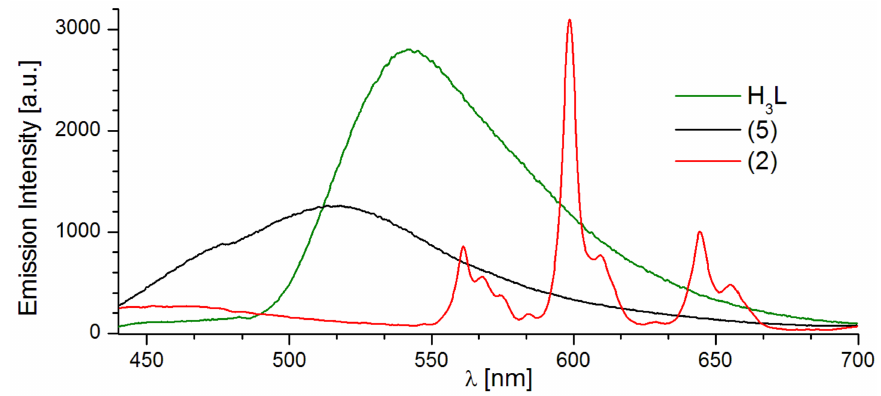
Figure 7. Solid state emission spectra of H 3 L ligand and complexes 2 (Zn II –Sm III –Zn II ) and